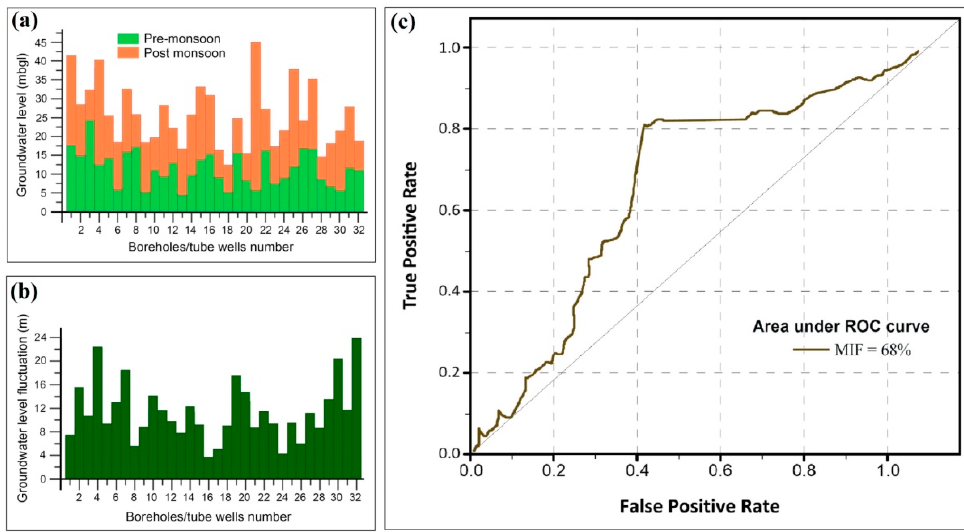
Figure 8. ( a ) The pre-monsoon and post-monsoon groundwater level (mbgl) fluctuations; ( b ) aver- age groundwater level fluctuation (m) of the Karak watershed; ( c ) receiver operating characteristics (ROC) curve of the MIF model. Table 5. Error matrix of the GW pot zone-based confusion matrix and Kappa (K) analysis. S. No